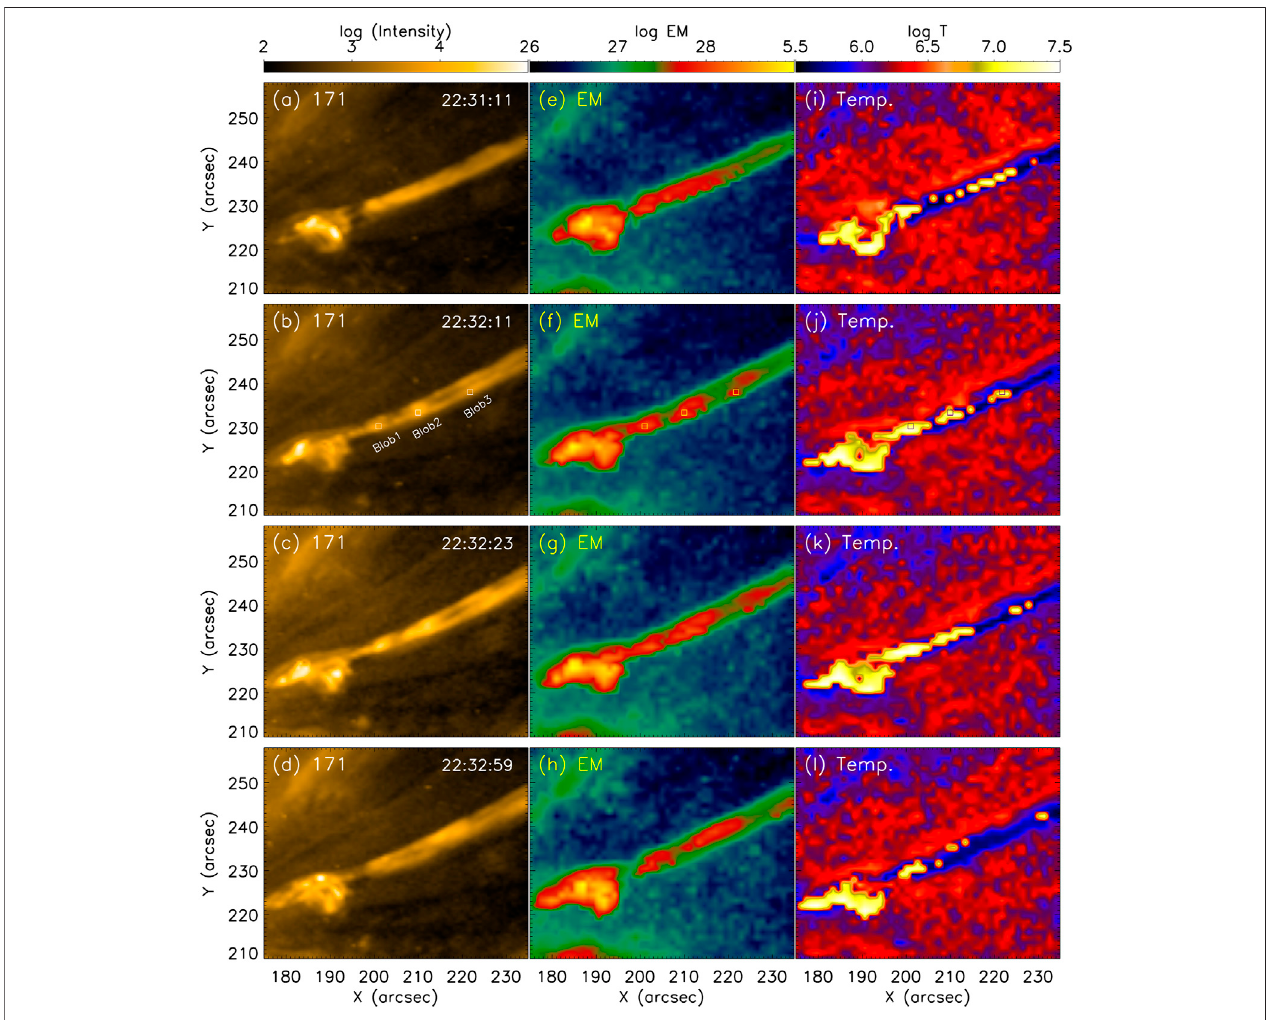
FIGURE 8 | Column 1: evolution of the jet in Phase 2 with the blob formation in 171 Å at four consecutive snapshots with time indicated in the upper right corner in eachpanel.Column2:emissionmeasureofPhase2atthesametimeasindicatedincolumn1.Column3:temperatureofPhase2atthetimesasofcolumn1.FOV:60 ′′ × 48 ′′